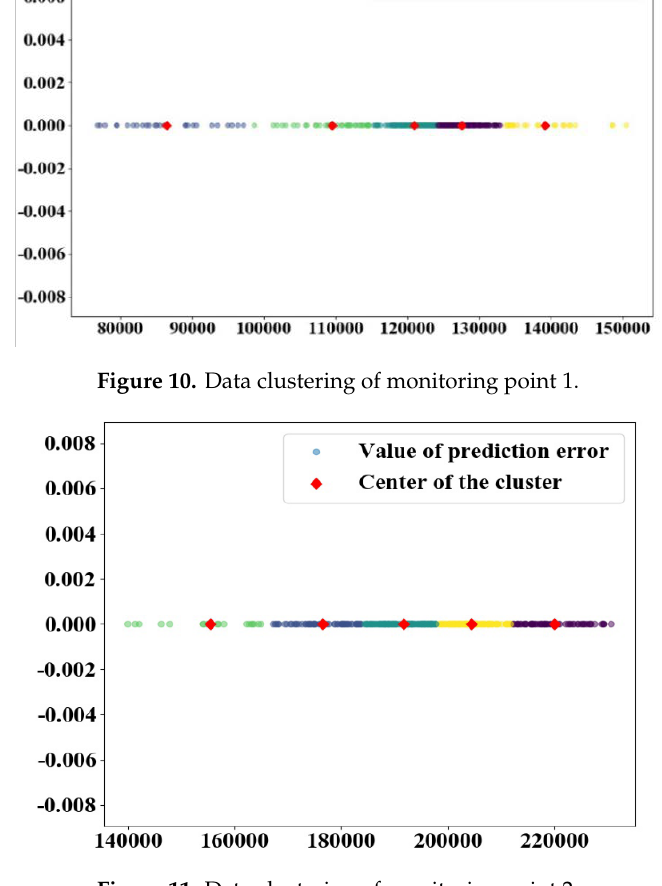
Figure 11. Data clustering of monitoring point 2.